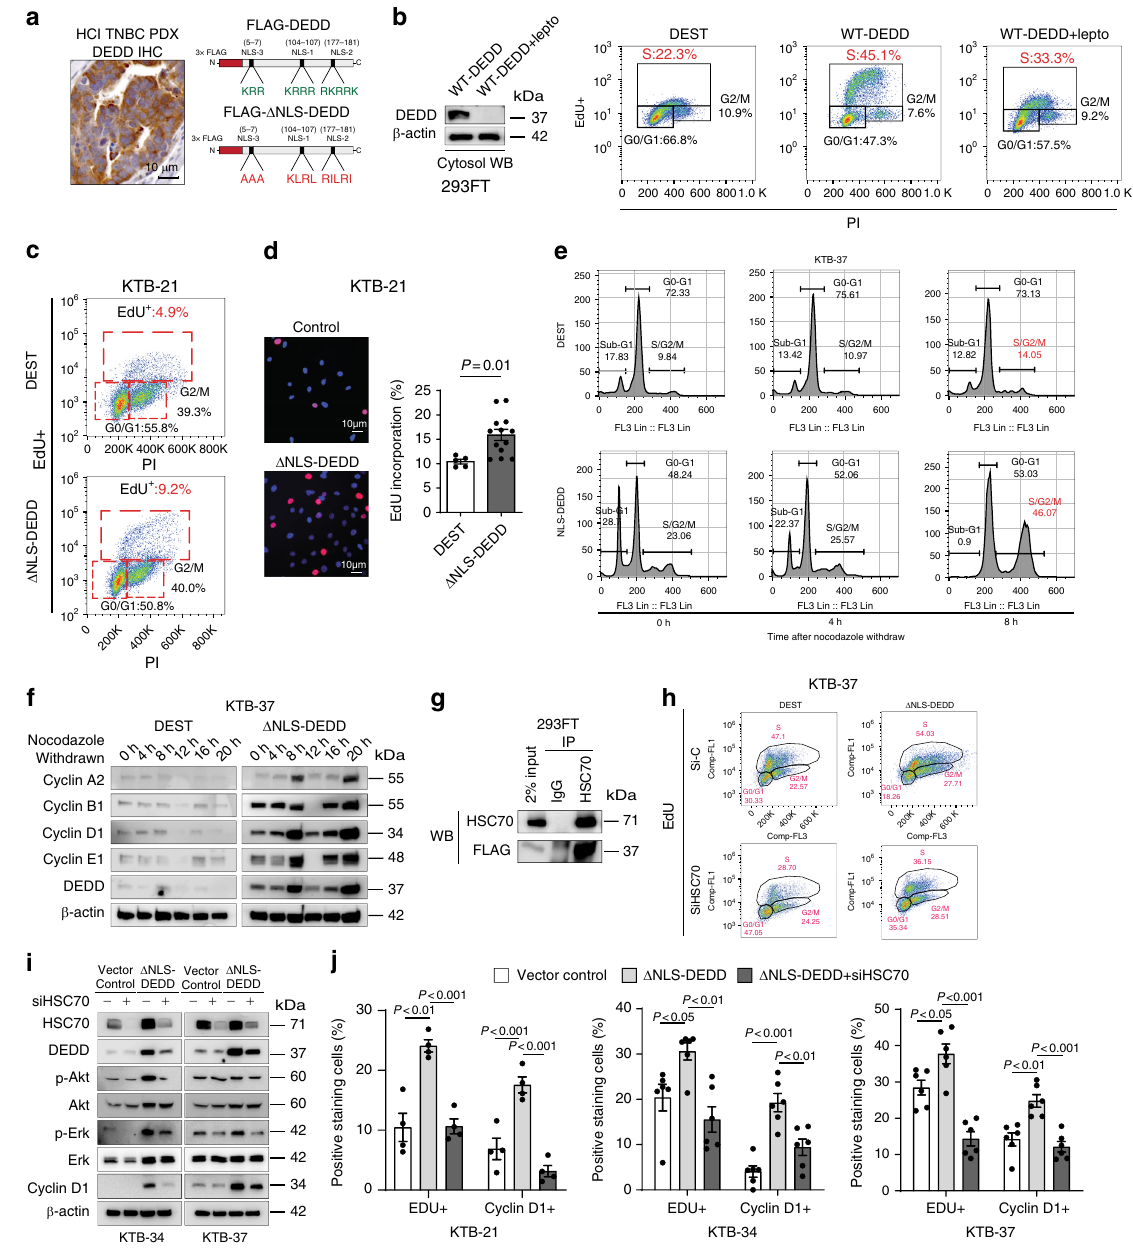
Fig. 3 Death effector domain-containing DNA-binding protein ( DEDD ) mediates heat-shock cognate 71kDa protein (HSC70)-dependent G1/S progression and cyclin D1. a , Left: immunohistochemistry (IHC) staining of DEDD in triple-negative breast cancer (TNBC) patient-derived xenograft (PDX) tissue. Right: Schematic of 3×-FLAG-tagged wild-type DEDD nuclear localization sequence (NLS) location and its mutated form. b , Left: Western blot showing FLAG- DEDD expression in 293FT cells with or without cytosol shuttle inhibitor leptomycin treatment (10 μ g/mL, 3h). Right: Representative fl ow cytometry biaxial plots of 293FT cells showing 5-ethynyl-2 ′ -deoxyuridine (EdU) incorporation with or without expression of wild-type DEDD or cytosolic DEDD ( Δ NLS- DEDD ). c Representative fl ow cytometry biaxial plots of KTB-21 cells showing EdU incorporation with or without expression of cytosolic DEDD ( Δ NLS- DEDD ). DEST: control vector. d , Left: Representative immuno fl uorescence staining showing EdU incorporation of KTB cells with or without expression of cytosolic DEDD . 4 ′ ,6-Diamidino-2-phenylindole (DAPI): Blue; Red: EdU. Right: Quanti fi cation of EdU incorporation assay. e Representative fl ow cytometry biaxial plots of KTB-37 cells showing EdU incorporation with or without the expression of cytosolic DEDD after cell cycle release from nocodazole treatment (100ng/mL) for 24h. f Immunoblots showing cyclin pro fi les as well as DEDD expression of control plasmid or Δ NLS- DEDD -overexpressed normal mammary epithelial cells (KTB-37) at different time points after cells withdrawn from nocodazole treatment (100ng/mL). g Immunoprecipitation assay showing the interaction between cytosolic DEDD and heat- shock cognate 71kDa protein (HSC70) after overexpressing 3×-FLAG-DEL-NLS- DEDD plasmid in 293FT cells. h Representative fl ow cytometry biaxial plots showing EdU incorporation of HSC70-knockdown KTB-37 cells with or without the expression of cytosolic DEDD . i Western blots showing cell signaling changes of KTB cell lines with or without the treatment of HSC70 small interfering RNAs (siRNAs) for 2 days. j Bar chart showing the percentage of the immuno fl uorescence staining positive cells expressing either cytosolic DEDD or control vector in KTB cell lines with/without the treatment of HSC70 siRNAs for 2 days. Blue: DAPI; Red: EdU + . All quantitative data were generated from a minimum of three replicates. P values were derived from one- way analysis of variance (ANOVA) with multiple comparison test. Error bars represent